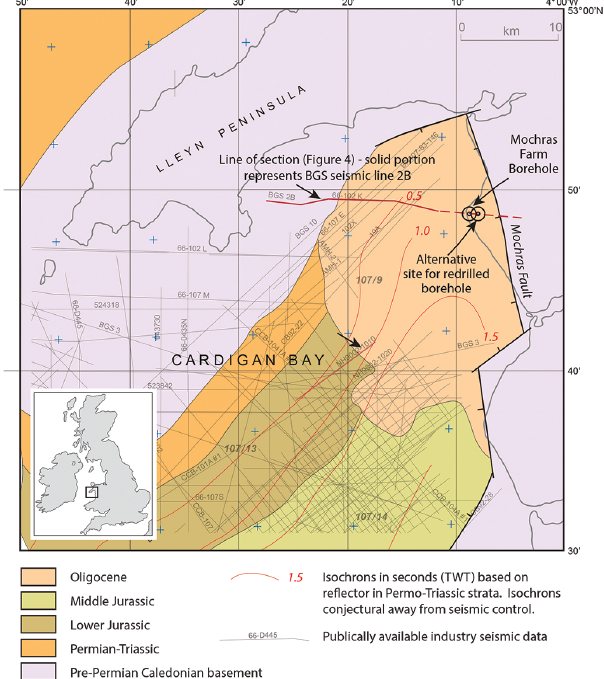
Figure 2. Simplified o ff shore and onshore geological map for the Cardigan Bay area showing existing and alternative borehole sites together with publically available seismic reflection survey data (based on Dobson and Whittington, 1987; Tappin et al., 1994; British Geological Survey 1:25000 map of Cardigan Bay, Solid Geology).